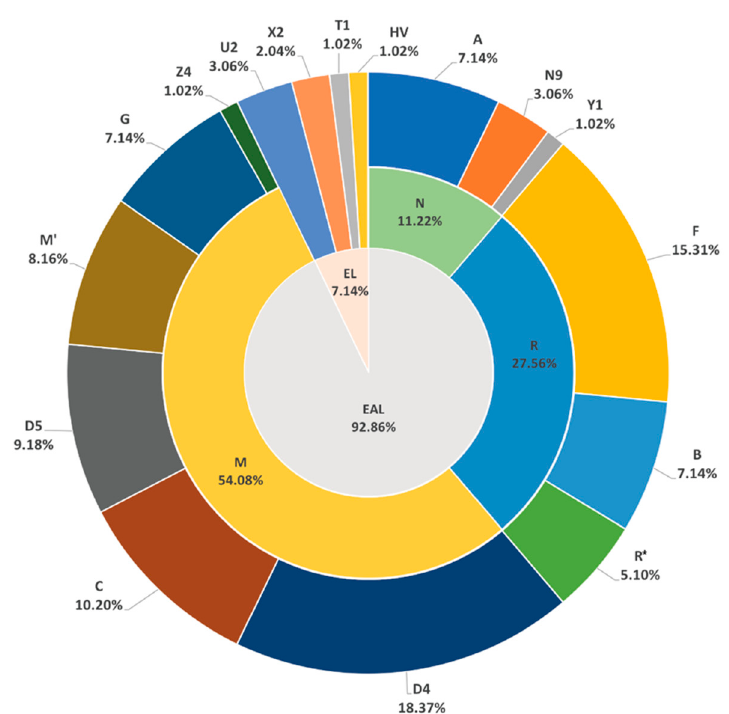
Figure 1. The mitochondrial haplogroup distributions of 98 Hui individuals from Northwest China. European-specific lineages represented by EL, and East Asian-specific lineages represented by EAL.